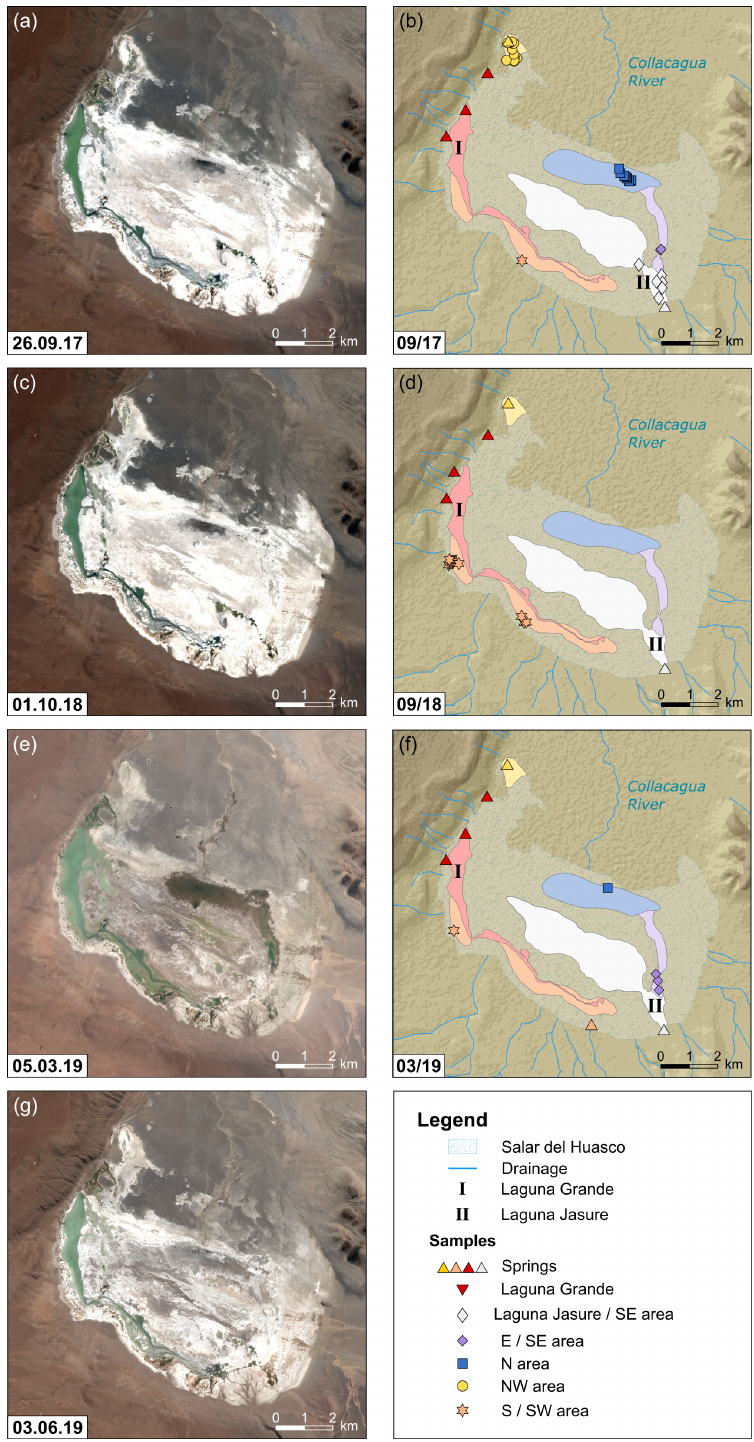
Figure 2. Illustration of the hydrological situation at the Salar del Huasco over the sampling period with sample locations for field campaigns in September 2017 (a, b) , September 2018 (c, d) , and March 2019 (e, f) . Panel (g) reflects the hydrological situation at the Salar del Huasco 6 months after the last sampling campaign. Several hydrological subsystems (coloured areas) were identified based on satellite images (Copernicus Sentinel data, 2017, 2018, 2019) and field observations. Different symbols of sample locations refer to the corresponding hydrological subsystem (see text for details; DEM derived from SRTM data, created using ArcGIS 10.5.1).